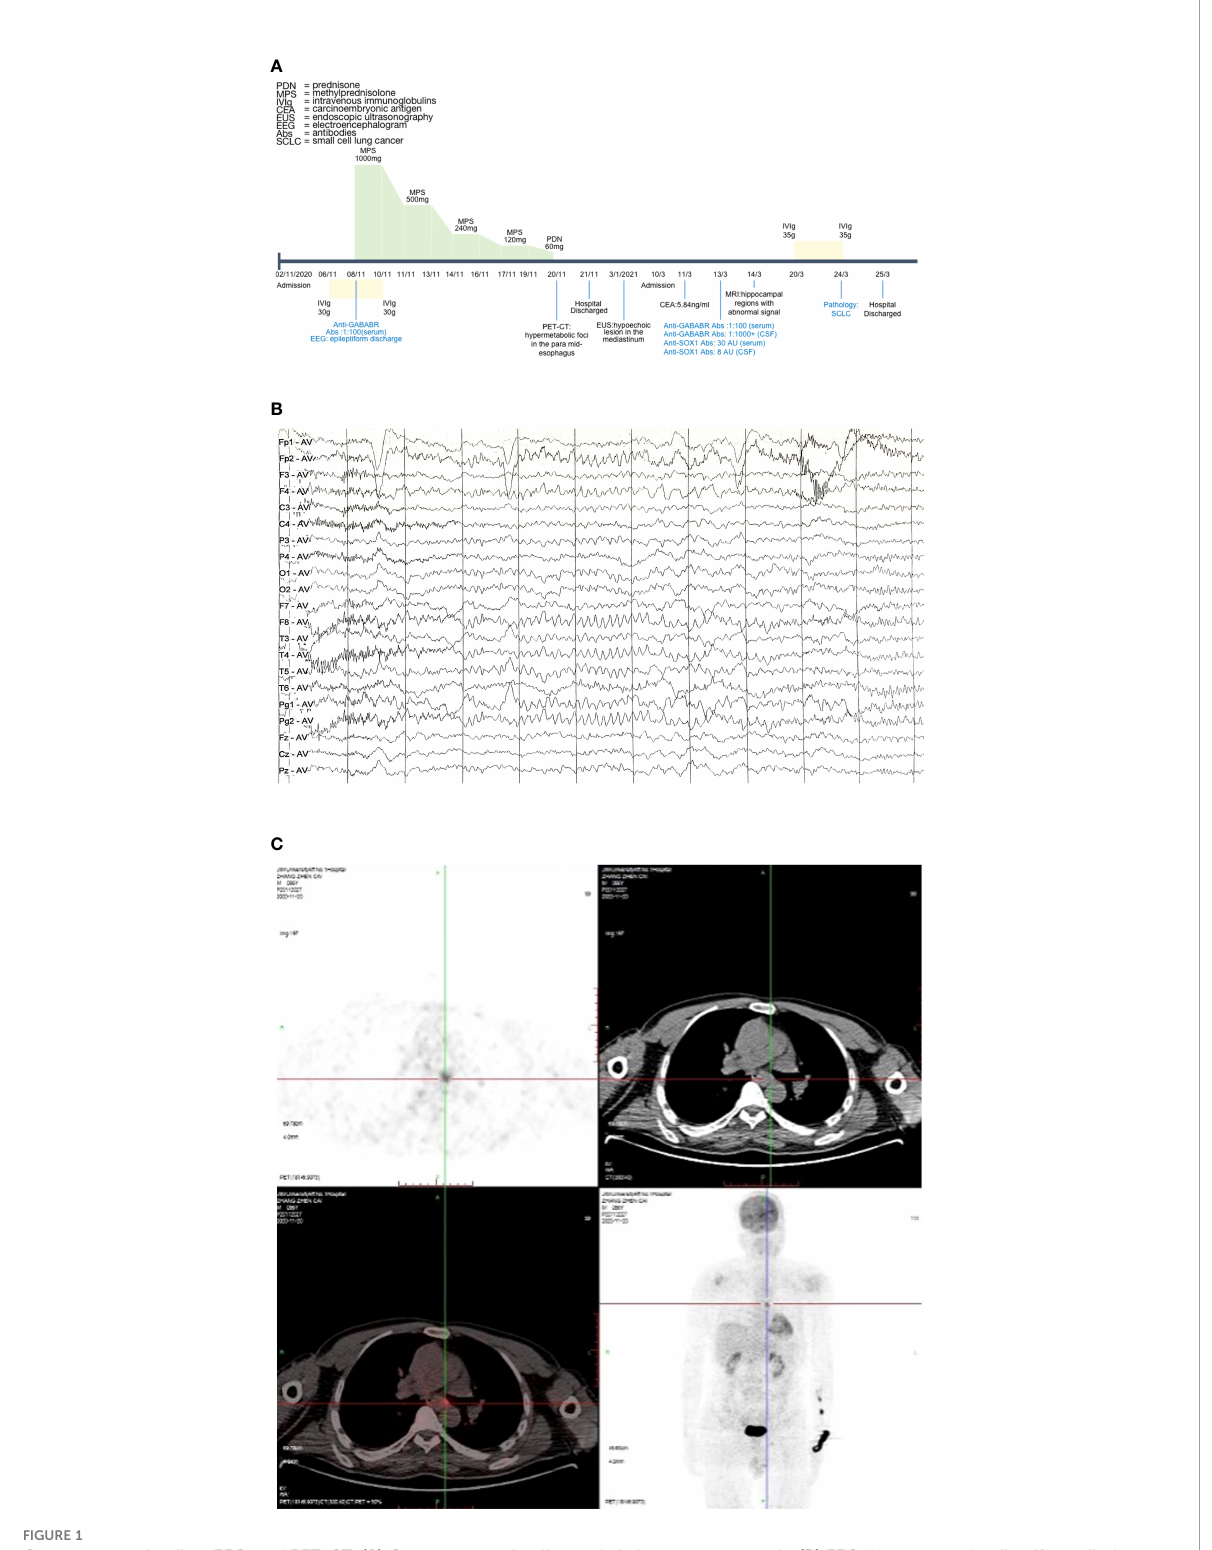
FIGURE 1 Case progress timeline, EEG, and PET-CT. (A) Case progress timeline and vital treatment records. (B) EEG demonstrated epileptiform discharge. (C) PET-CT suggested that the metabolism of para mid-esophageal was increased. The lesion was about 1.7 cm*0.6 cm, the maximum value of SUV was 4.4, and the lesion was poorly demarcated from the adjacent esophageal wall. EEG, electroencephalogram; PET-CT, positron emission tomography-computed tomography; SUV, standard uptake